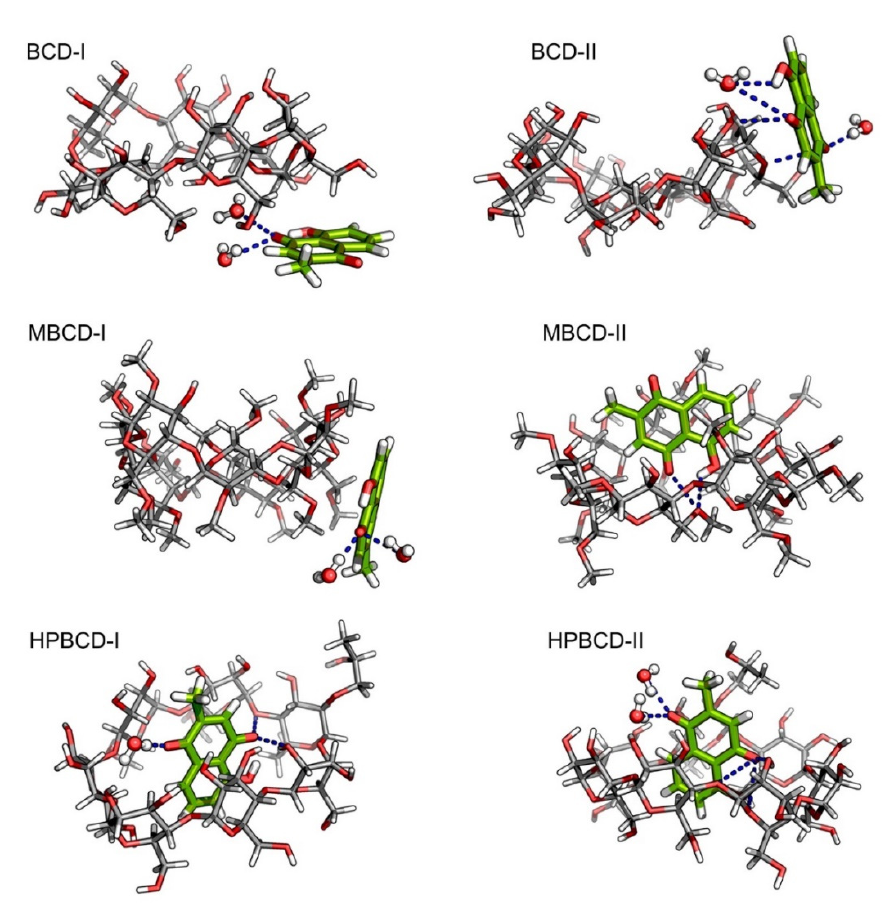
Figure 5. Illustrations of snapshot at 145 ns from all plumbagin–BCDs inclusion complexes. Plumbagin and BCDs molecules are presented as green and light gray stick models, respectively. The bound water molecules are presented as ball and stick models. In all molecules, oxygen and hydrogen atoms are highlighted with red and white colors, respectively. The blue dash lines represent the hydrogen bonds.